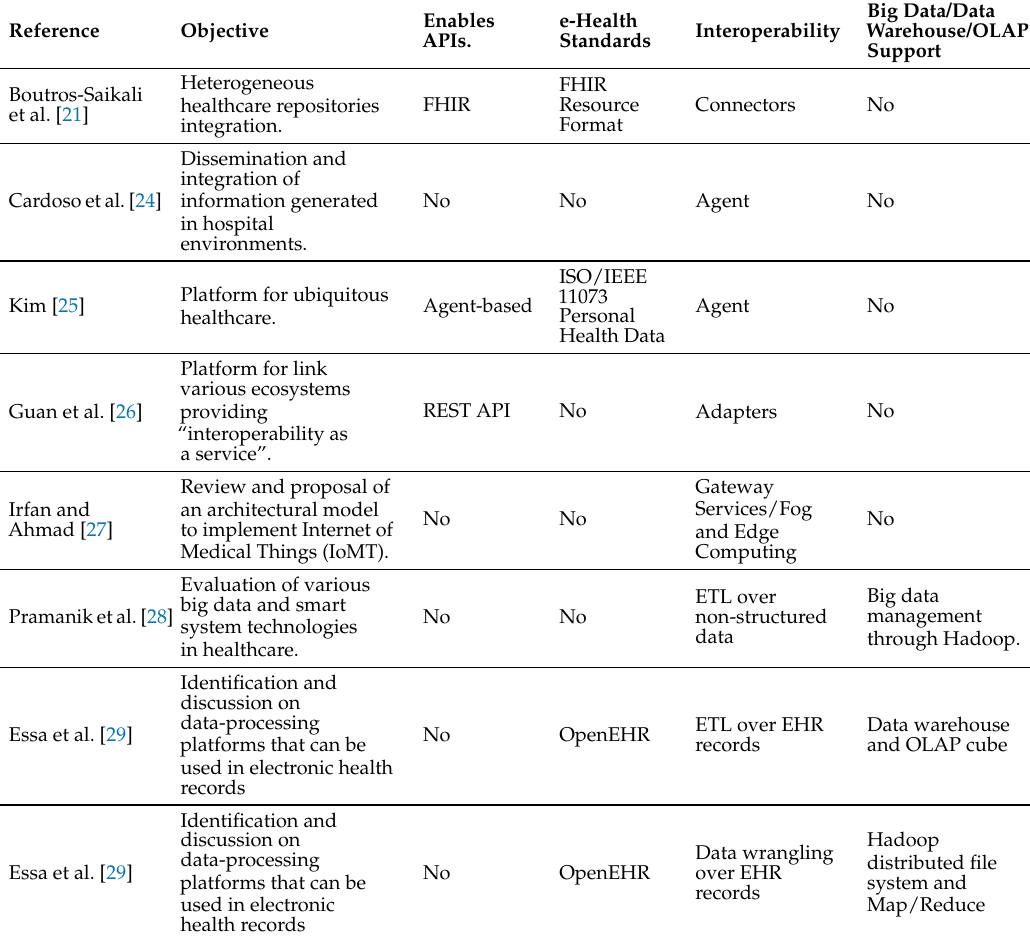
Table 1. Comparison of related